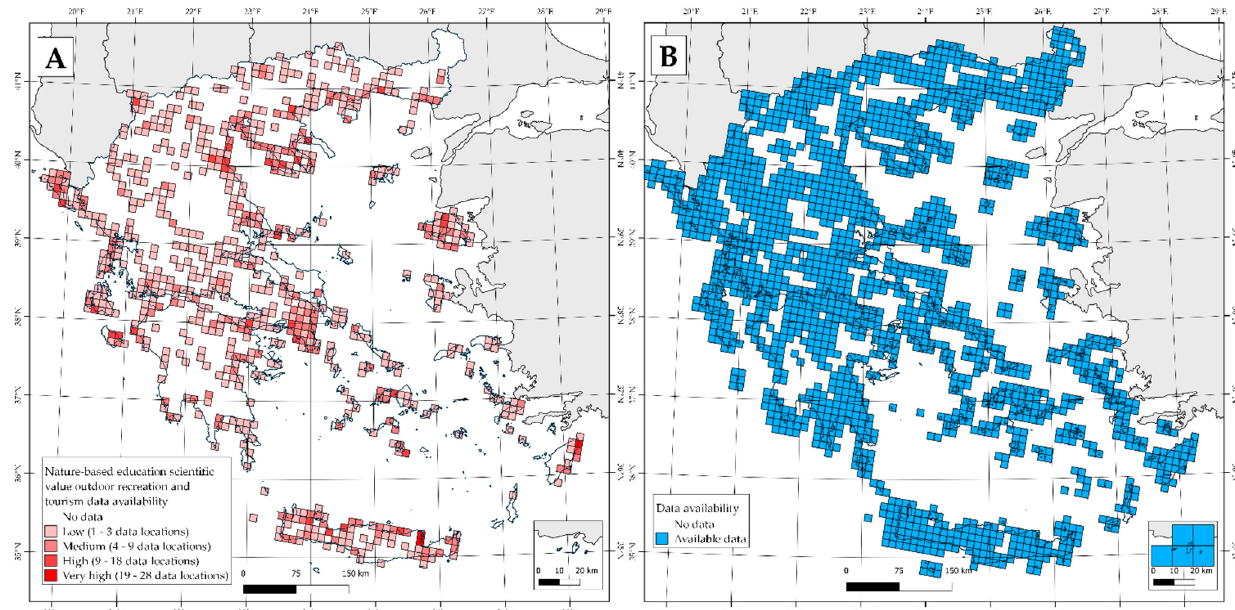
Figure 9. Example of gap analysis using the European Environment Agency (EEA) 10 × 10 km reference grid. ( A ) Data availability after the combination of two categories; i.e., nature-based education and scientific value and outdoor recreation and tourism. ( B ) Total data availability of the five CES categories assessed in the study.